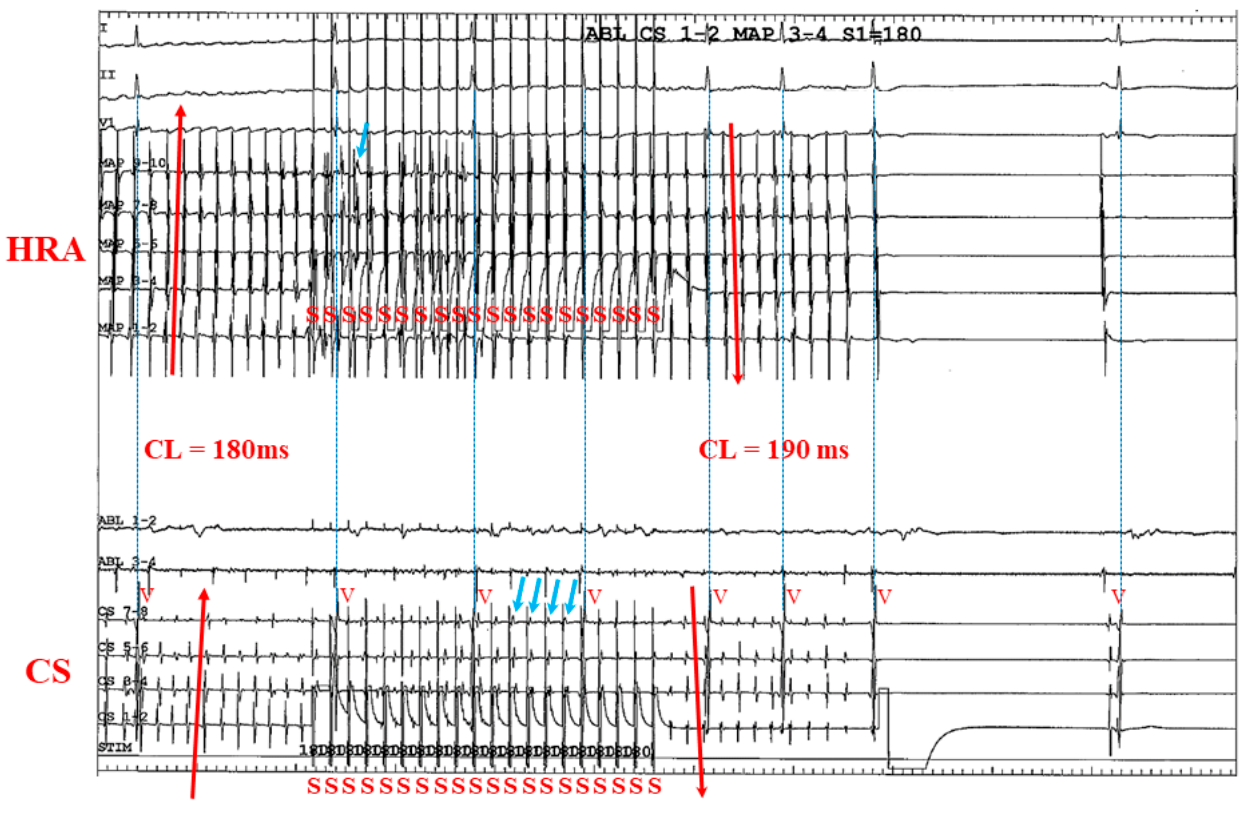
Figure 7. A representative case involving a 60-year-old man with symptomatic PAF undergoing ablation which hypothesizes one mechanism of AF termination. During simultaneous biatrial straight pacing from the CS and HRA, 1/20 pacing impulses captured the HRA and 4/20 pacing impulses captured the CS (right blue arrows). However, the atrial activation sequences across both the HRA and CS catheters became reversed: At both CS and HRA catheters, the activation sequence changed from “distal to proximal” to “proximal to distal” after A-ATP (red arrows) before termination of AF. AF = atrial fibrillation; CL = cycle length; CS = coronary sinus; HRA = high right atrium; PAF = paroxysmal AF; S =